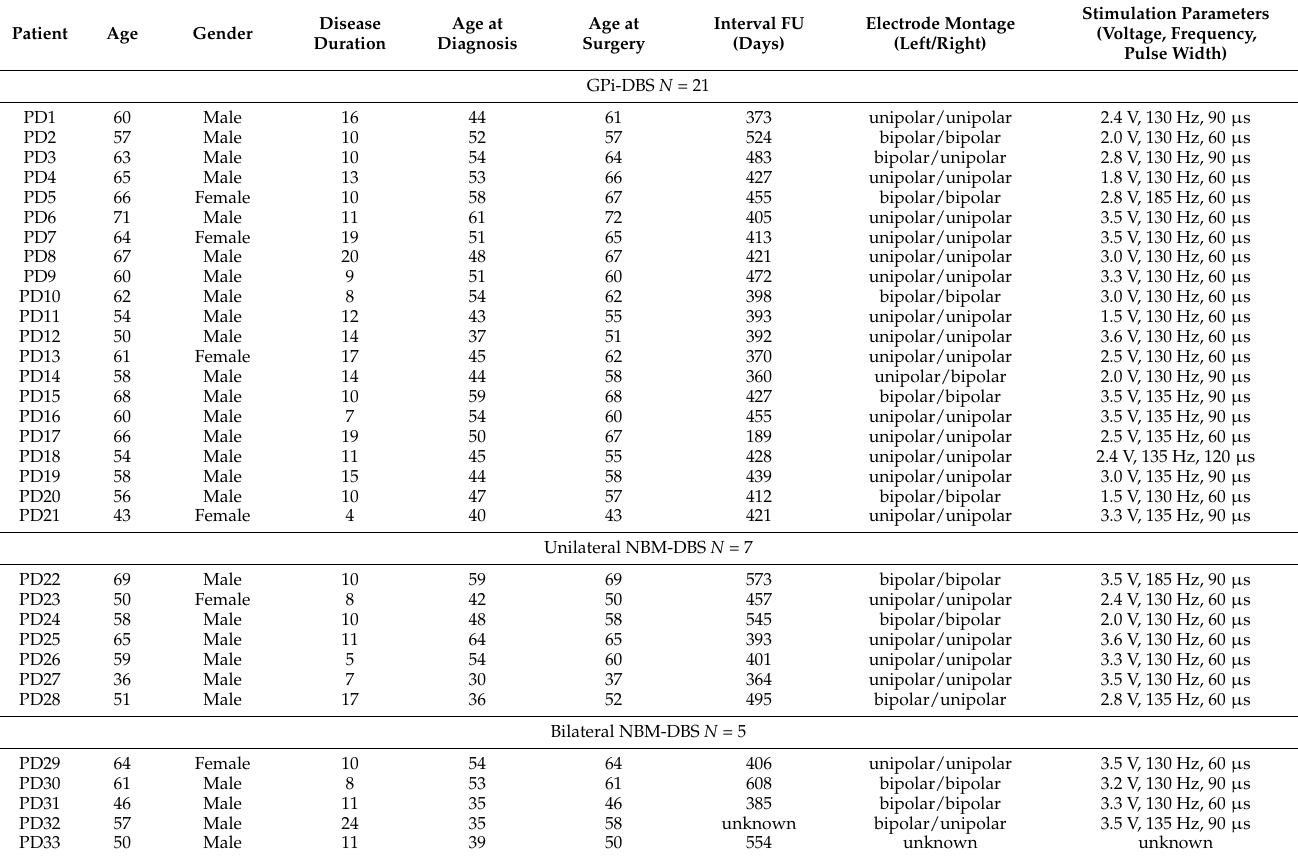
Table 3. Neuropsychological outcomes at baseline and following one year of DBS.